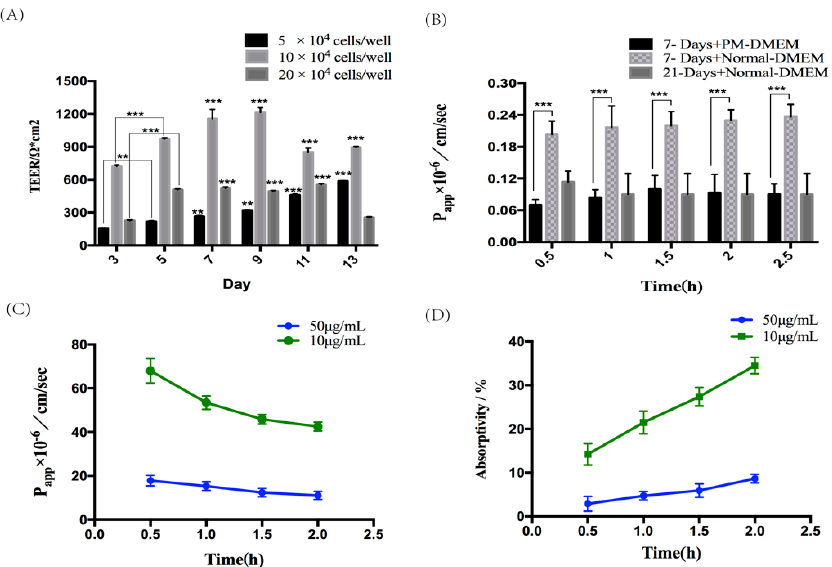
Figure 3. Establishment and assessment of seven-day absorption model of Caco-2 cells. ( A ) The transmembrane resistance (TEER) comparison at different concentration of Caco-2 cell density which were cultured in Puromycin -Dulbecco’s modified Eagle’s medium (PM-DMEM) medium. ( B ) The P app of the markers of paracellular transport was expressed as the means ± SD ( n = 3). ( C ) The Papp of FITC-transferrin at different time and concentration was expressed as the means ± SD ( n = 3). ( D ) The absorptivity of FITC-transferrin at different time and concentration was expressed as the means ± SD ( n = 3).